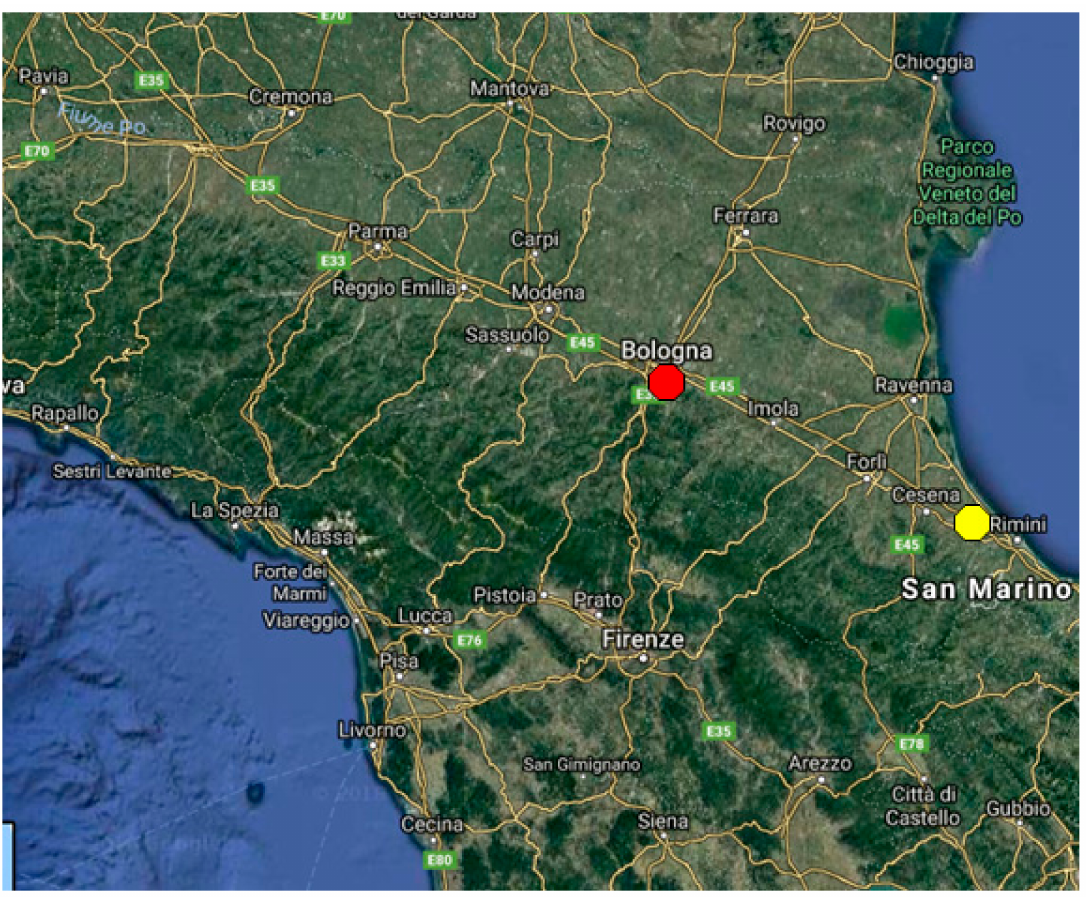
Figure 3. Map showing the epicenter of the 4.1-magnitude earthquake (yellow point) occurred on 13 October 2010 with epicenter 100 km far from the monitoring site in Bologna (red